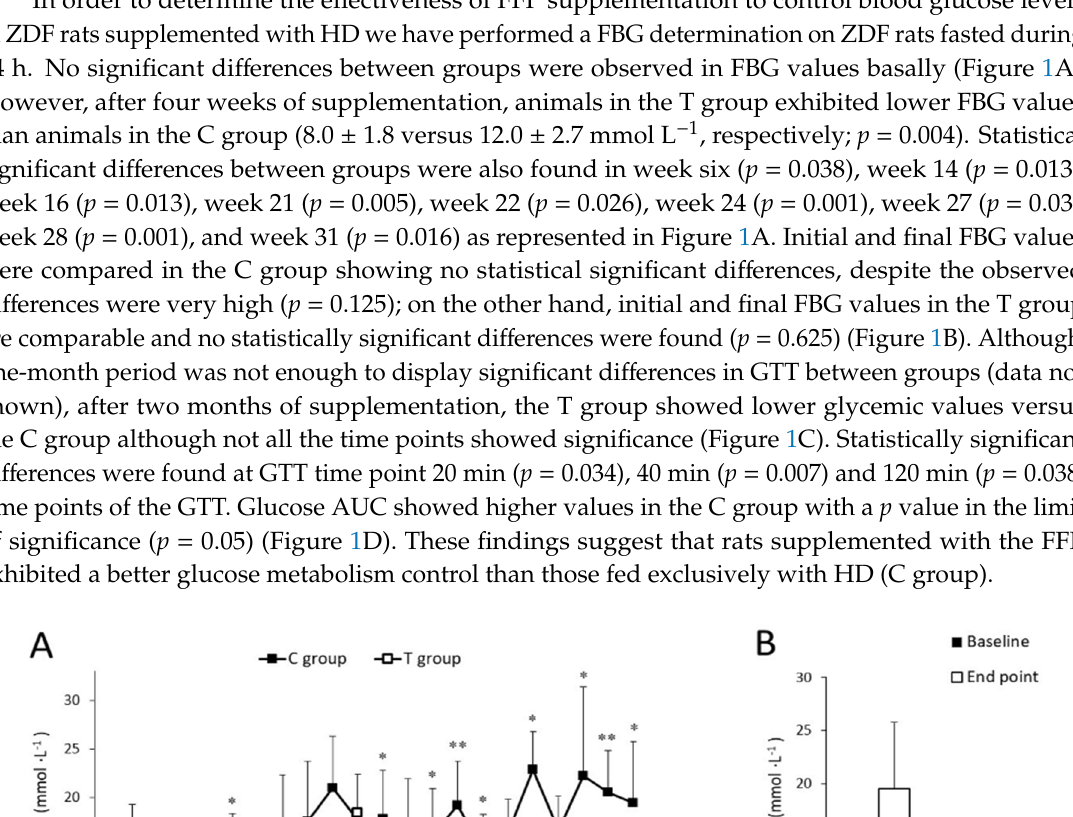
Figure 1. Effect of the fermented food product (FFP) on glucose metabolism. ( A ) Weekly fasting blood glucose (FBG) progression in Zucker diabetic fatty (ZDF) rats. Animals in T group showed lower FBG mean values than animals in C group during the study. Statistically significant differences were found at 4, 6, 14, 16, 21, 22, 24, 27, 28, and 31 weeks ( p = 0.004, p = 0.038, p = 0.013, p = 0.013, p = 0.005, p = 0.026, p = 0.001, p = 0.030, p = 0.001, and p = 0.016, respectively). ( B ) Bar plots represent basal and end point FBG values in the groups. No statistical significant differences were found between basal and end point FBG values in any groups (7.2 ± 1.3 versus 19.5 ± 6.3 mmol L −1 at 0 and 31 weeks, respectively in C group; 7.6 ± 1.8 versus 8.2 ± 1.6 mmol L −1 at 0 and 31 weeks respectively in T group). ( C ) Two- months glucose tolerance test (GTT) curve. The GTT curve, after two months of FFP supplementation, showed lower blood glucose levels and statistically significant differences between groups were found at 20, 40, and 120 min ( p = 0.034, p = 0.007, and p = 0.038, respectively). ( D ) Area under the curve (AUC) plot. The AUC value was lower in T group (3622.5 ± 1040.4) compared to C group (4454.0 ± 590.9) although the p value obtained was in the limit of significance ( p = 0.05). Values are expressed as mean ± SD. wk = week. * p < 0.05, ** p < 0.01.